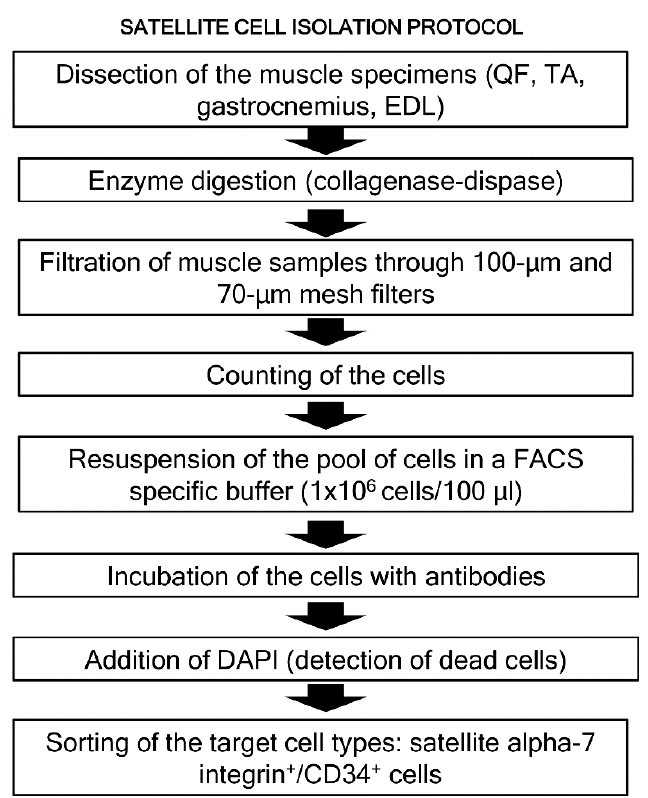
Figure 2. Representative flowchart corresponding to the isolation protocol of the satellite cells using FACS analyses in the mouse limb muscles. Each specific step is described in a box and the flow of the entire protocol is indicated by the dark thick arrows. Definition of abbreviations: QF, quadriceps femoris; TA, tibialis anterior; EDL, extensor digitorum longus; FACS, fluorescence-activated cell sorting; DAPI, 4’,6-diamino-2-fenilindol; α 7, alpha-7 integrin.